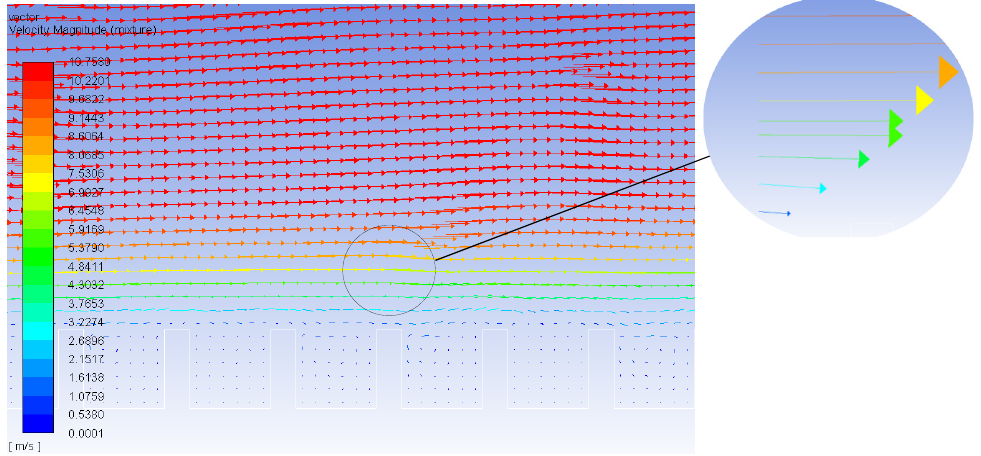
Figure 5. The overall velocity vector and the partially enlarged drawing (VOF model, 250,000 steps in FLUENT, θ r = 154°).